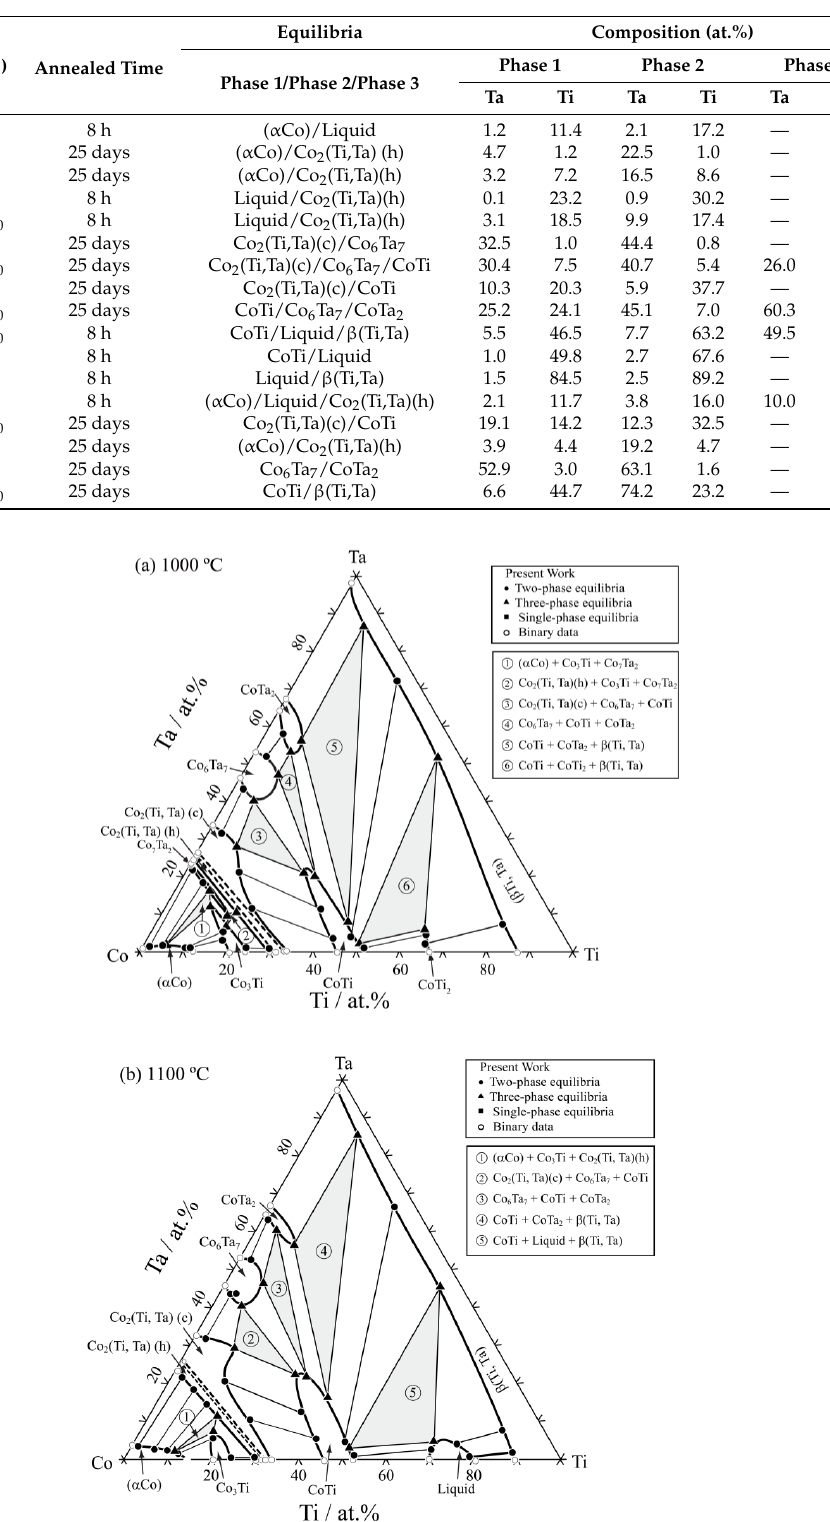
Table 4. Equilibrium composition of the Co-Ti-Ta ternary system at 1200 ◦ C determined in the present